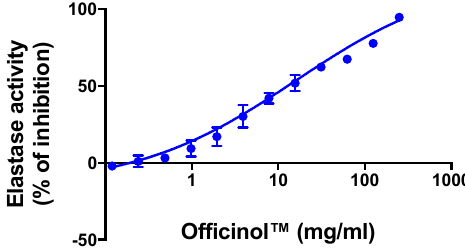
Figure 5. Concentration-dependent inhibition effect of Officinol™ on enzymatic elastase activity, a cosmetic target for wrinkle reduction. Graph on a logarithmic scale.